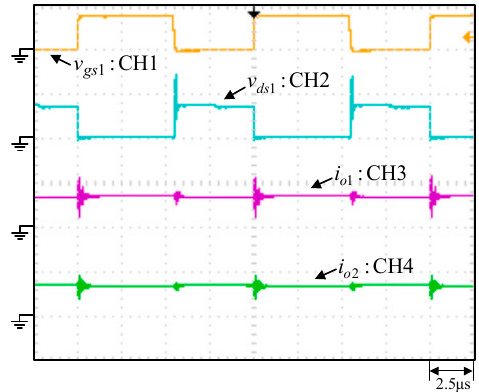
Figure 22. Waveforms at input voltage of 3.3 V [15]: (1) v gs 1 (20 V/div); (2) v ds 1 (10 V/div); (3) i o 1 (500 mA/div); (4) i o 2 (500 mA/div).